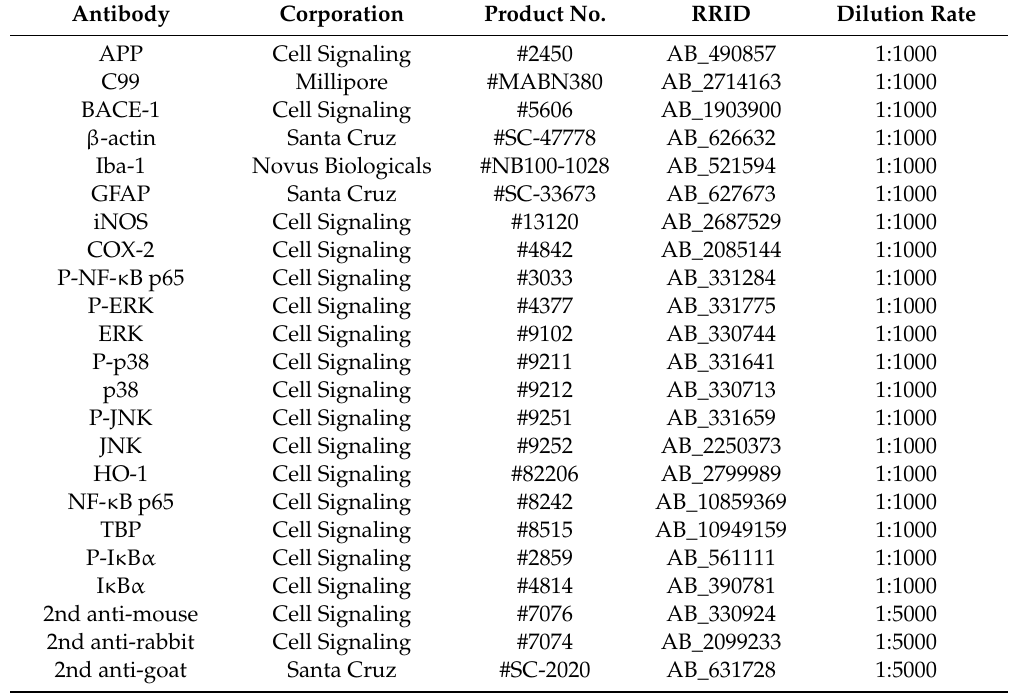
Table 2. Primary and secondary antibodies use for Western blot